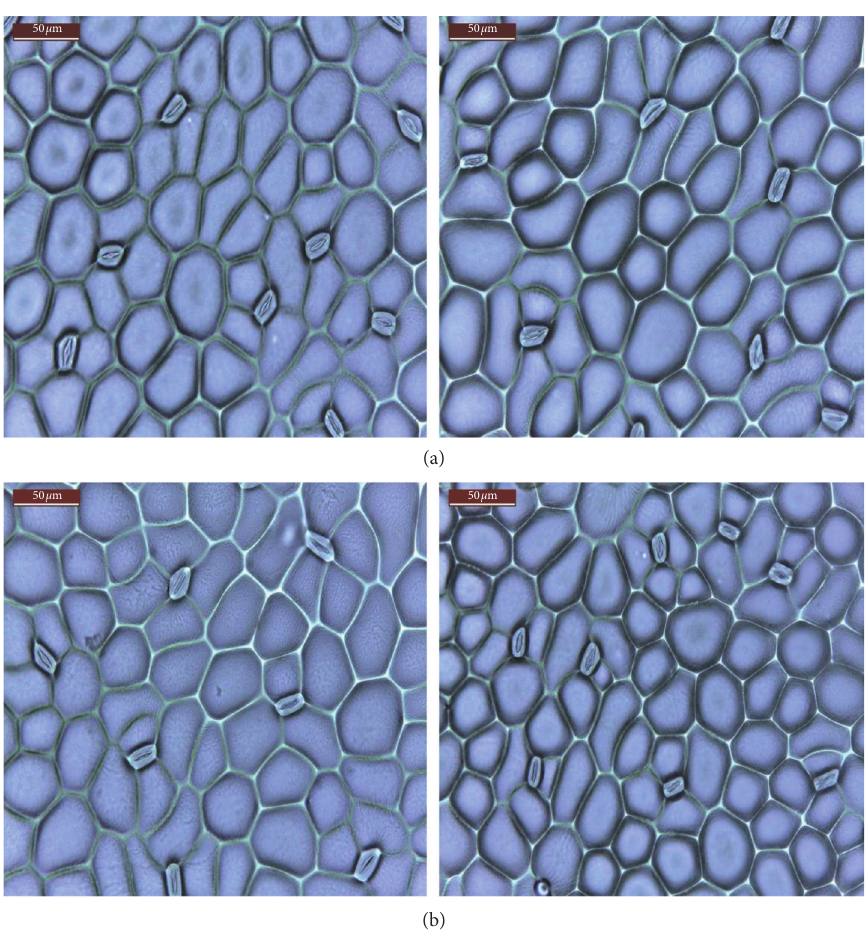
Figure 1: Example of collected microscopic imprints.